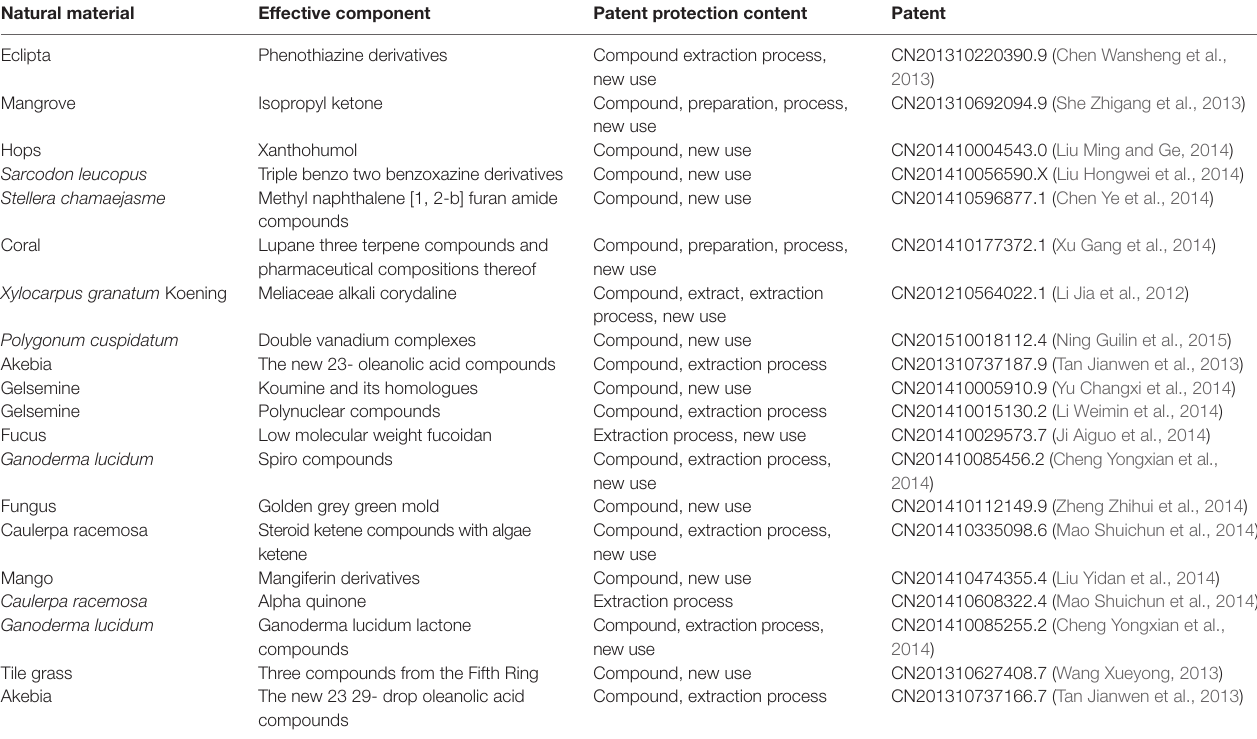
TABLE 1 | Twenty patents on phytochemical ingredients of herbal extracts in anti-diabetic properties, and their natural sources, and their protected